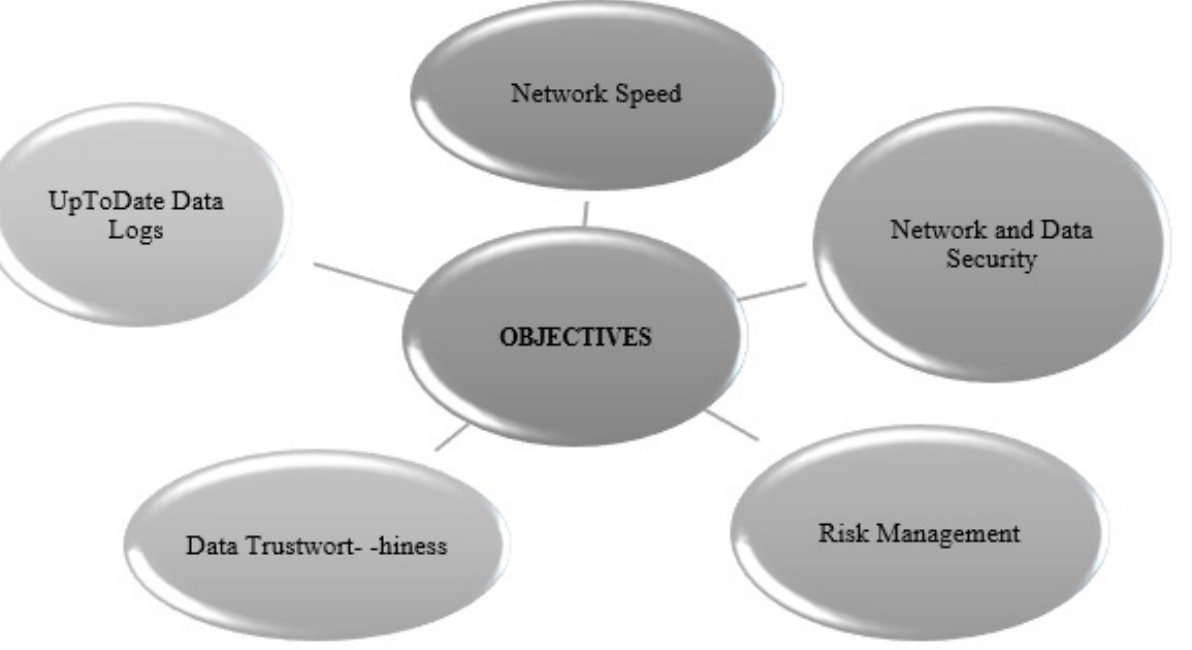
Figure 3. Objectives that need improvement.